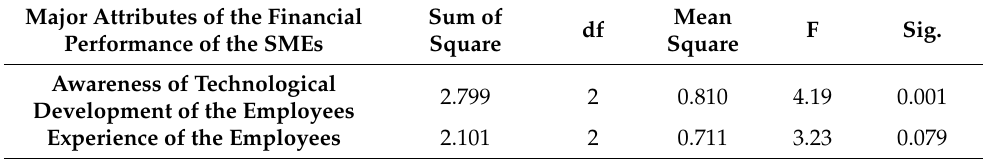
Table 20. Test of ANOVA.